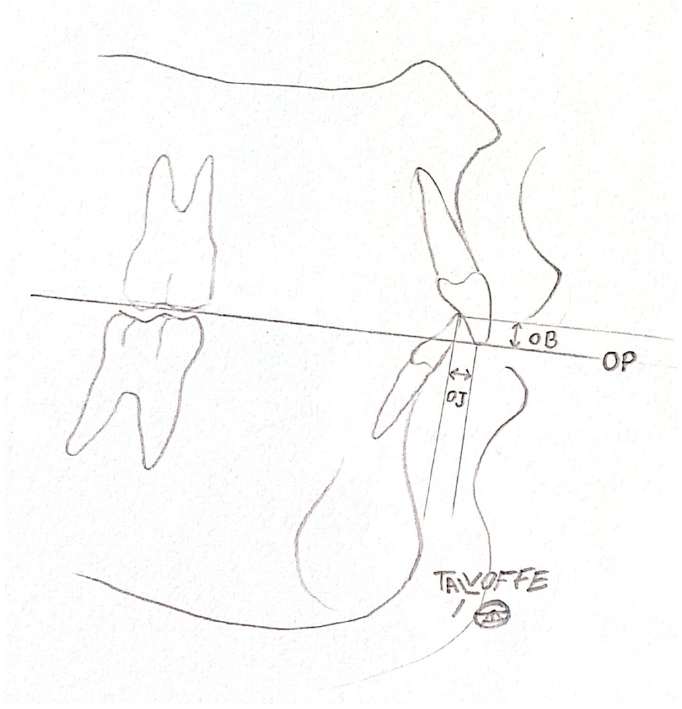
Figure 2. Lateral cephalometric X-ray measuring points. Abbreviations: OB—Overbite; OJ—Overjet.